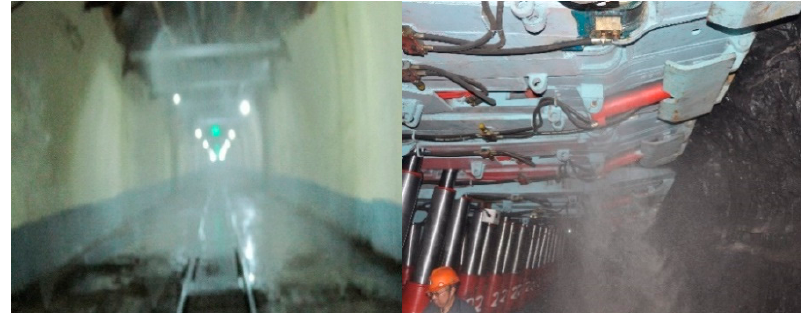
Figure 12. Swirl nozzle being used in a coal mine.